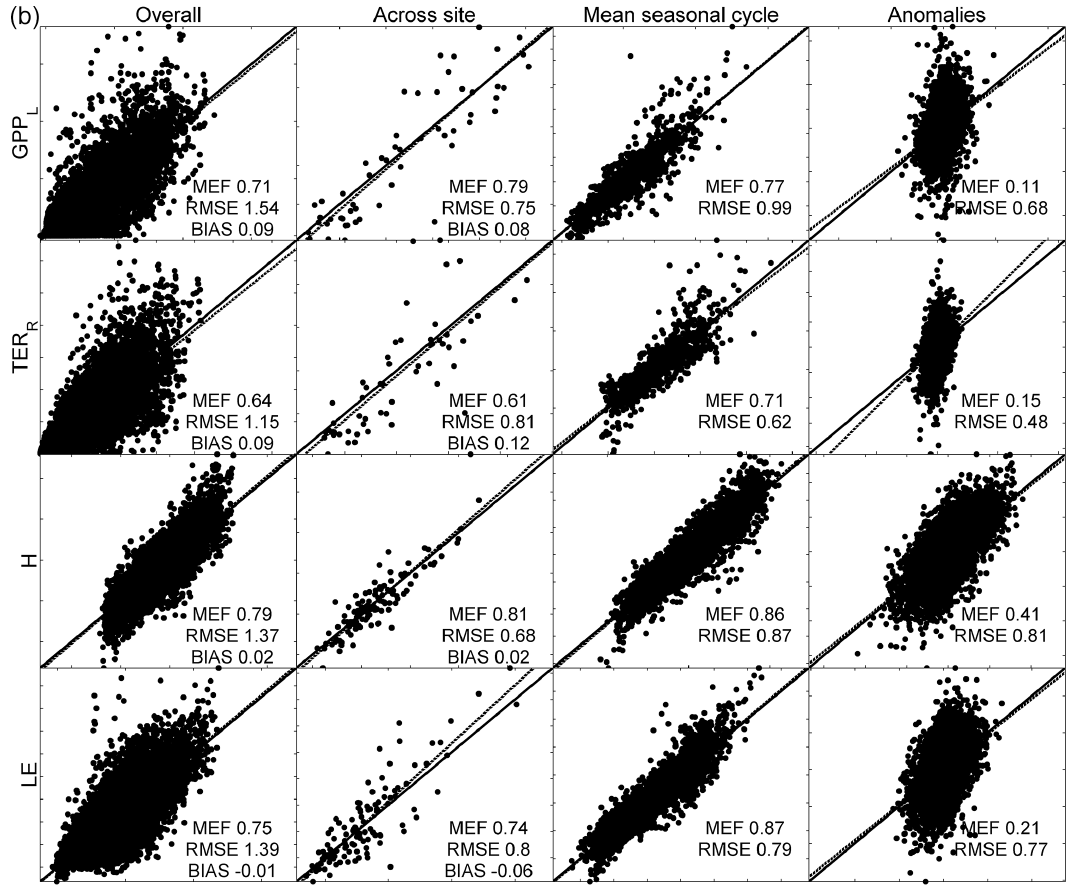
Figure 3. (a) Scatterplots of observed data by eddy-covariance ( y axis) and the median ensemble of modeled fluxes by RS setup ( x axis). The panels from left to right were the 8-day predictions, the across-site variability, the mean seasonal cycle and the 8-day anomalies. The fluxes considered here were the gross primary production estimated following Lasslop et al. (2010), GPP L (first row); the total ecosystem respiration estimated following Reichstein et al. (2005), TER R (second row); the sensible heat, H (third row); and the latent heat, LE (fourth row). The reference units were gCm − 2 d − 1 and MJm − 2 d − 1 for CO 2 fluxes (GPP L and TER R ) and energy fluxes ( H and LE), respectively. (b) As in Fig. 3a, but the predictions ( x axis) were obtained by the RS + METEO